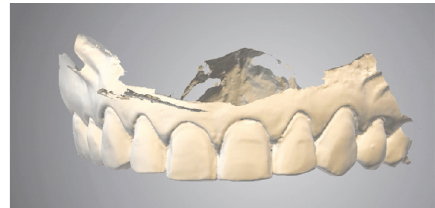
Figure 8: Finished tooth preparations.